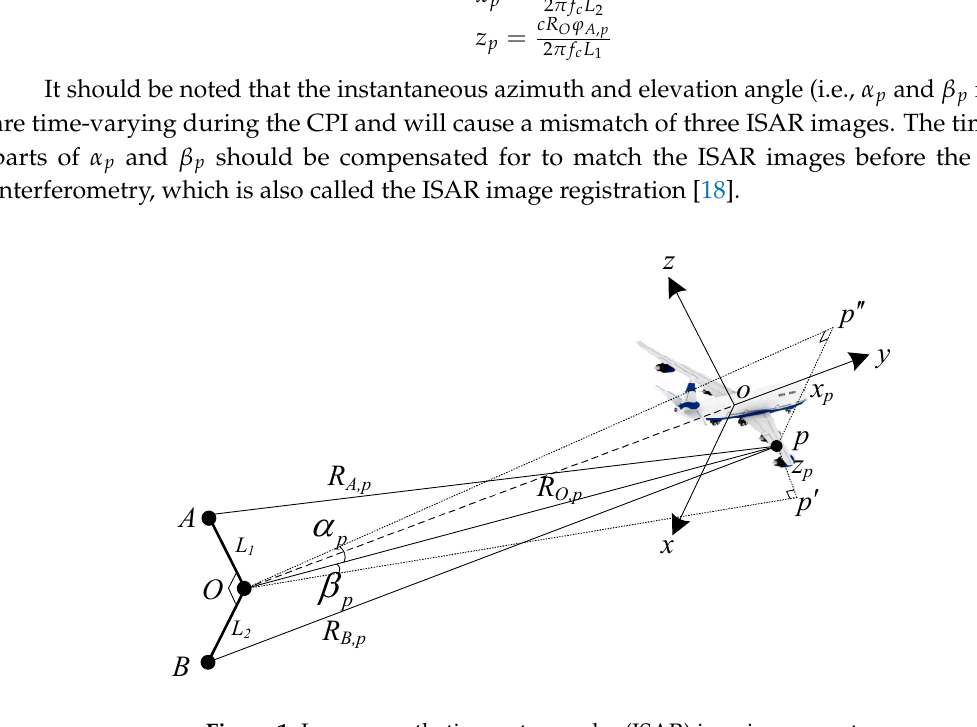
Figure 1. Inverse synthetic aperture radar (ISAR) imaging